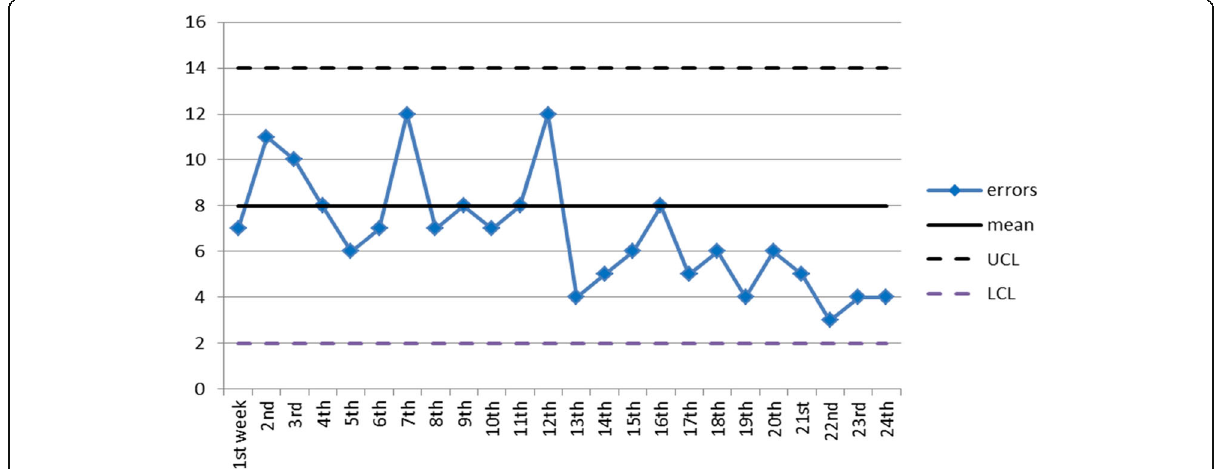
Fig. 4 Control chart of waste management performance errors. Weekly monitoring of errors in performance in waste management process as a process outcome measure, showing data shift by decreasing performance errors in waste management performance from the 13th week